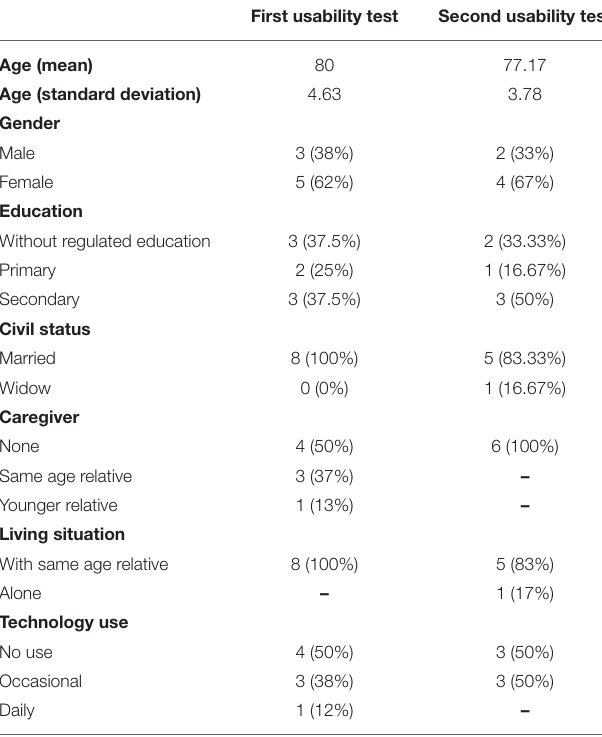
TABLE 1 | Summary of the demographic data in the two rounds of UX evaluation. TABLE 2 | Effectiveness measurement results: task completion rate and number of